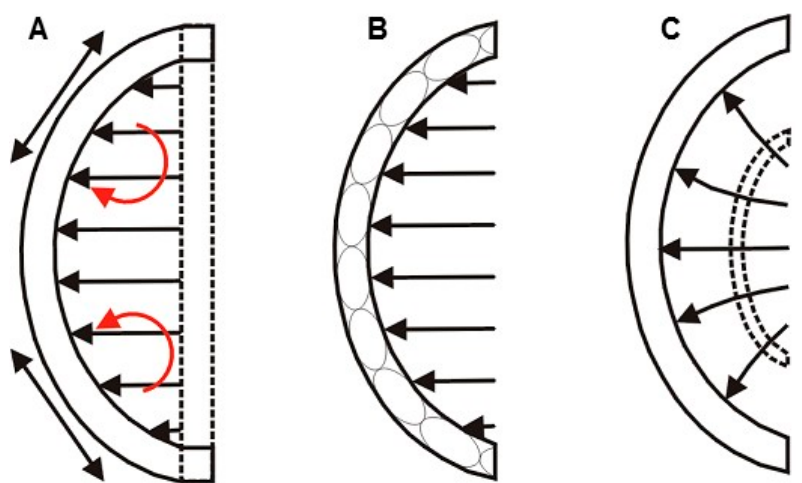
Figure 16. The classification of arcuate FTBs to ( A ) an “orocline” or a “secondary arc” that bends from a straight line to arcuate shape; ( B ) a “primary arc” which initiates as a primary arc; ( C ) a “divergent-transport arc” is formed by fan-shaped stress trajectories. The dashed area in (A) and (C) is the pre-deformational shape of the arc. Note that the first two types can also form with a divergent primary transport direction. Although the transport direction in the primary arc can be unidirectional, the shortening in the transverse deformation zone (oblique and lateral ramps) leads to considerable local deviation or vertical rotation of the finite strain axes from the regional direction of transport stresses [13,28–32,34,35]. This non-parallelism produces wrench deformation in oblique and lateral ramps.